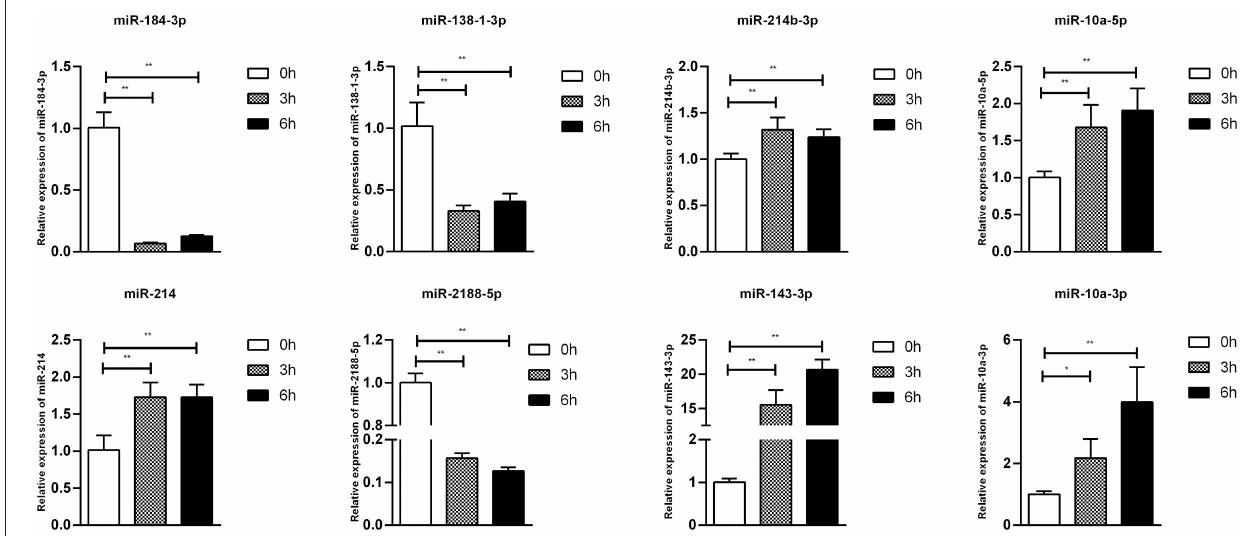
FIGURE 7 | Validation of miRNA differential expression results during SE infection in duck granulosa cells at 0, 3, and 6 hpi. qRT-PCR validation of miR-2188-5p, miR-138-1-3p, miR-184-3p, miR-214b-3p, miR-10a-5p, miR-214, miR-10a-3p, and miR-143-3p miRNA expression levels in cell samples between 0, 3, and 6 hpi. The miRNA expression levels at 3 and 6 hpi were normalized to the value at 0 hpi. Error bars indicate the mean ± SD of triplicate experiments. U6 snRNA was used as internal control to normalize miRNA expression. * P < 0.05; ** P < 0.01.